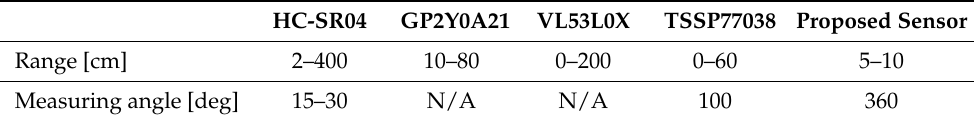
Table 2. Comparison of usable range and measuring angle for several used proximity and dis- tance